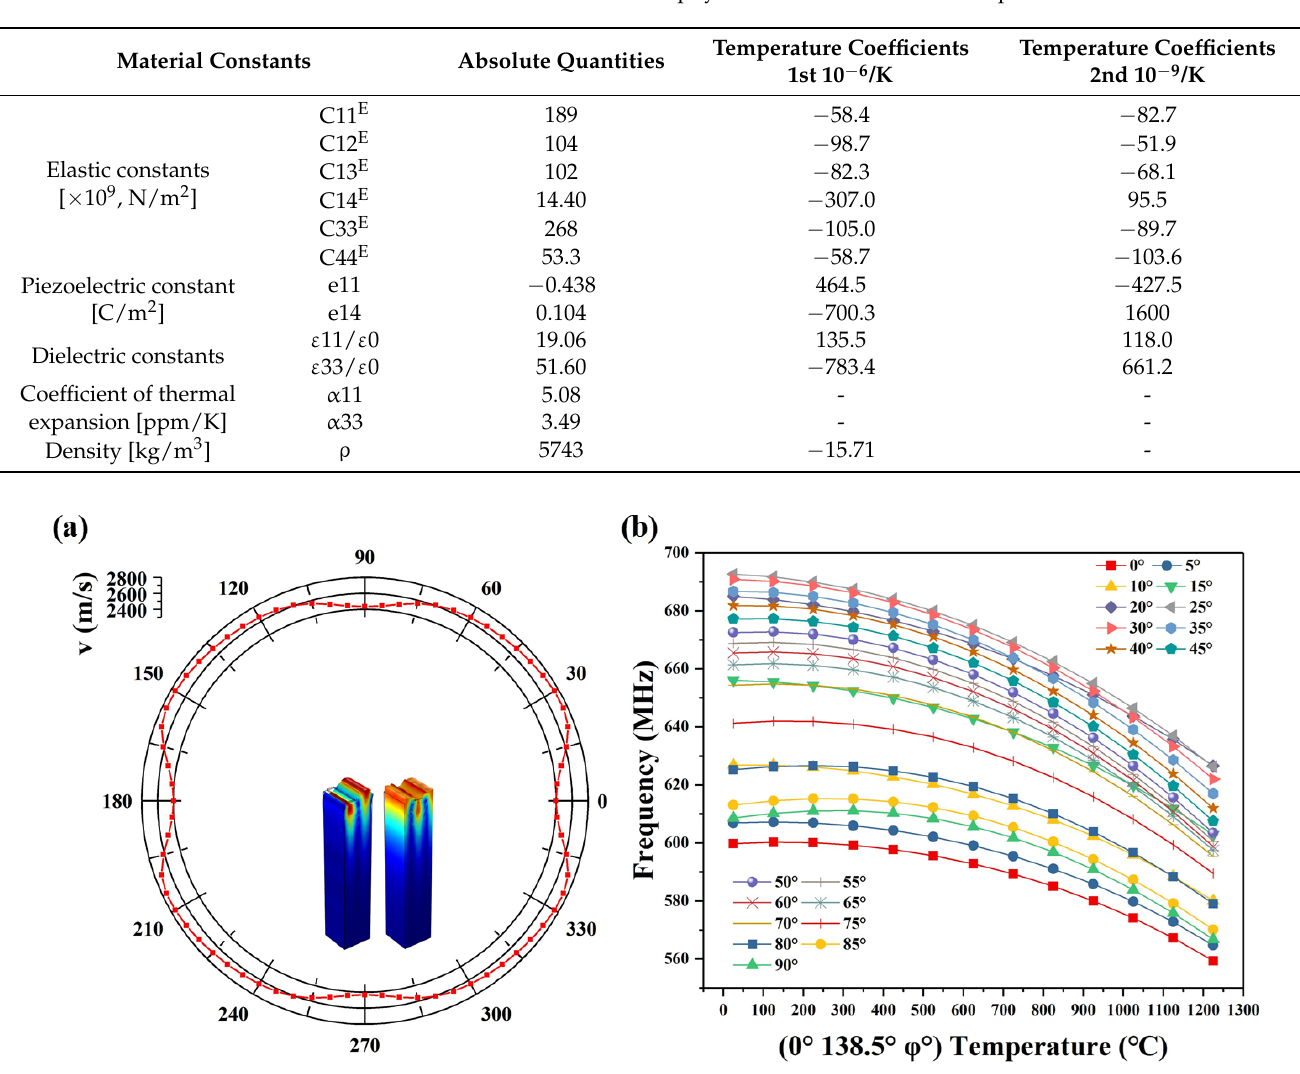
Table 1. The value of the acoustical physical constants and their temperature coefficient of LGS.